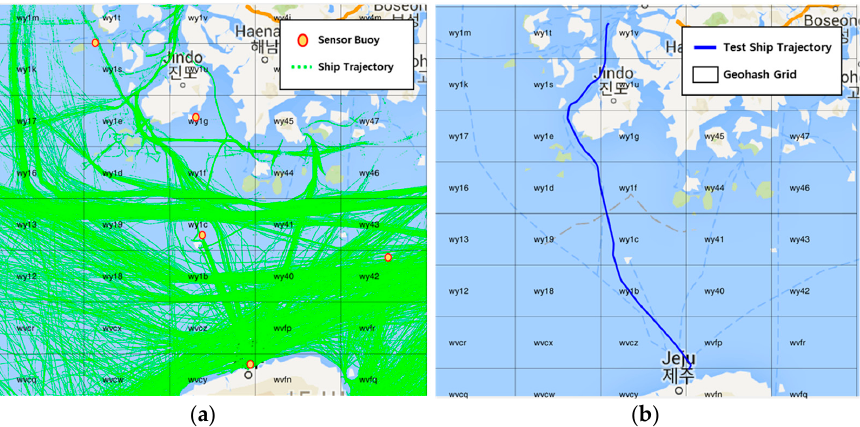
Figure 5. The southwestern sea of the Korean Peninsula for which the experimental data was collected. ( a ) Ship trajectories of traffic data and the location of sensor buoys used to collect the marine environmental data; ( b ) a liner route for optimal speed adjustments.